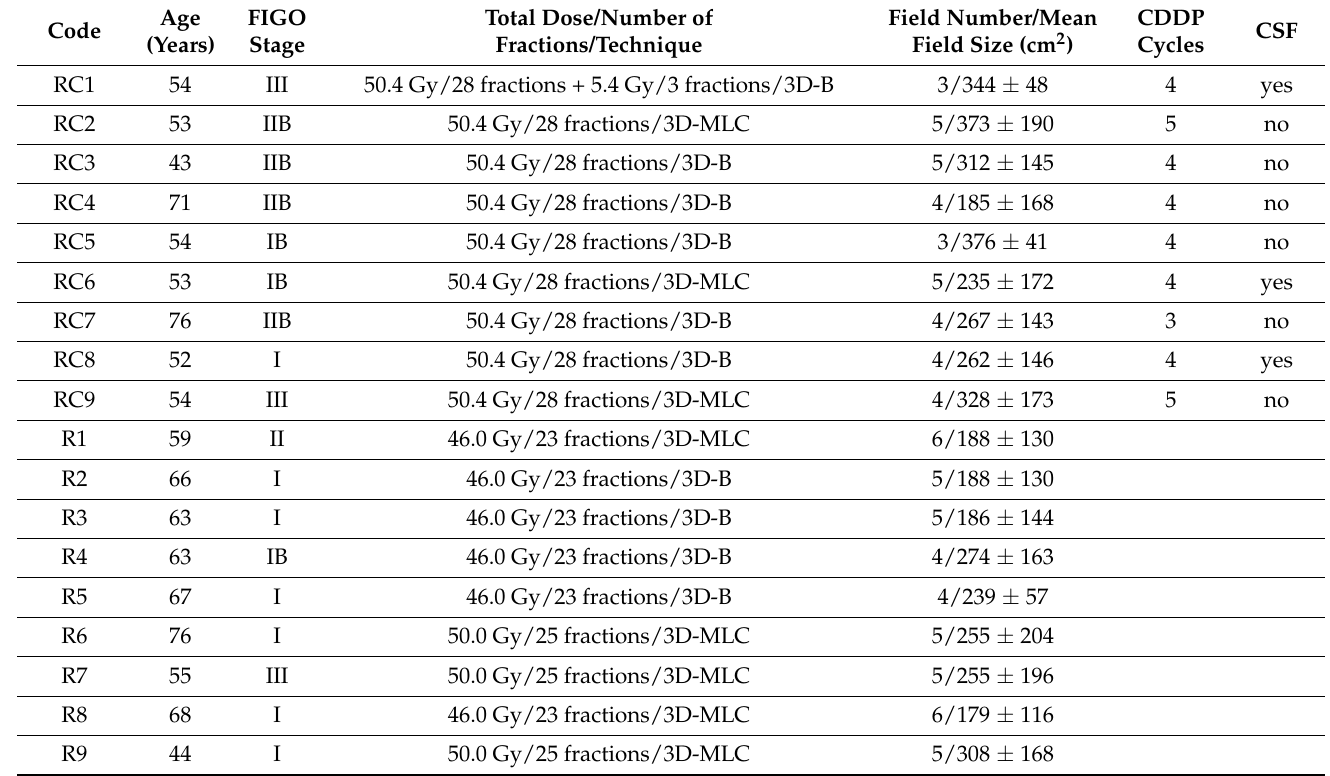
Table 1. Age and treatment details of RC and R